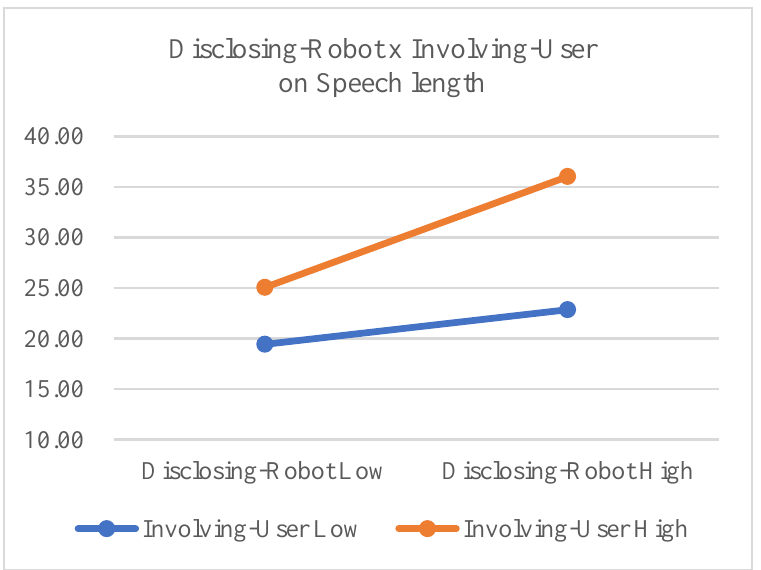
Figure 5. Interaction effects on speech length (between IVs).